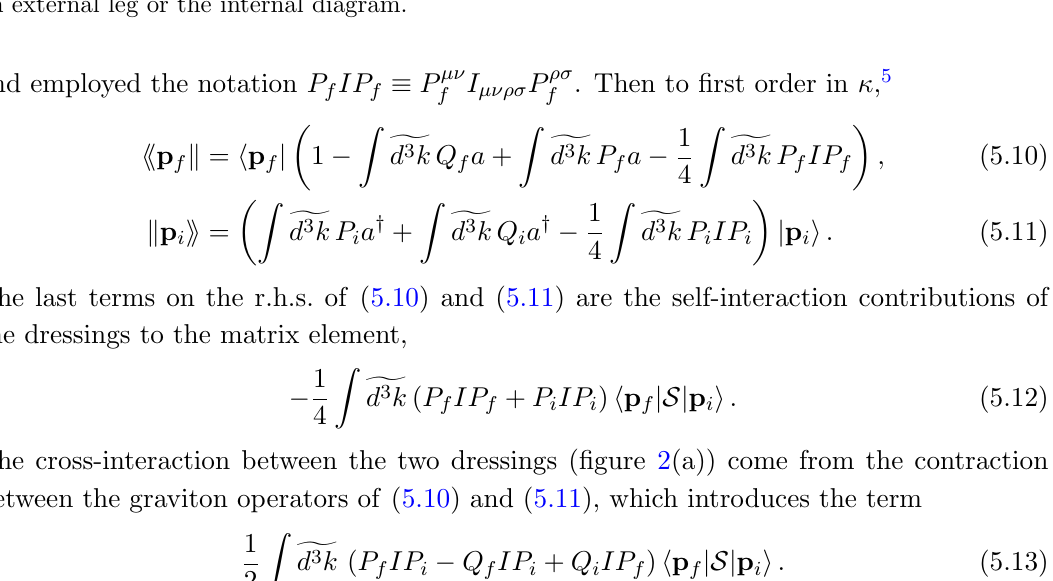
Figure 3. Contributions to the amplitude due to graviton exchange between a dressing and either an external leg or the internal